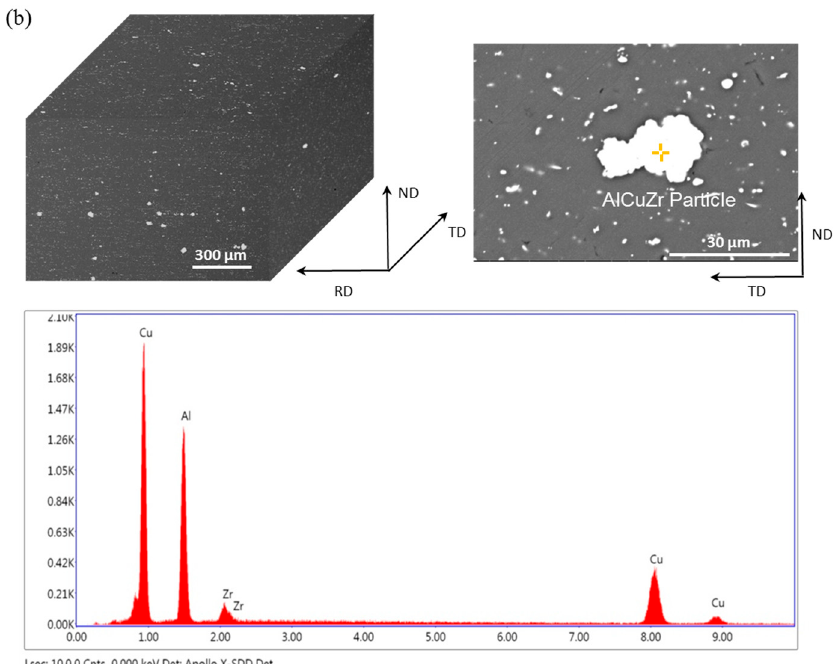
Figure 8. The characteristics and EDS analysis of the intermetallic in ( a ) Ce-containing and ( b ) Ce-free alloys after solid solution at 520 °C for 1 h.